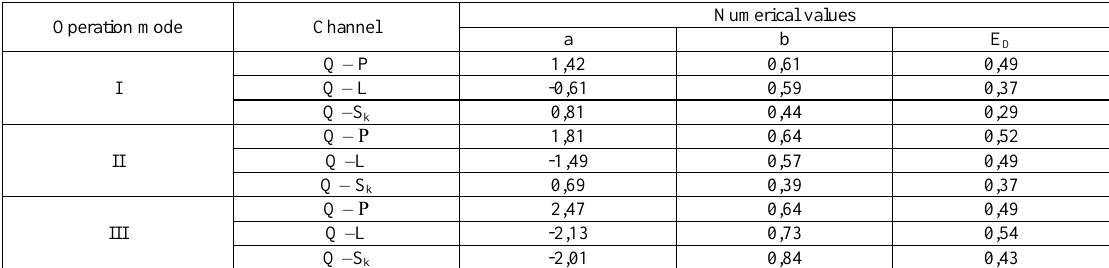
Table 5. Numerical values of the coefficients, band the degree of identity E D for one-dimensional models. Operation mode